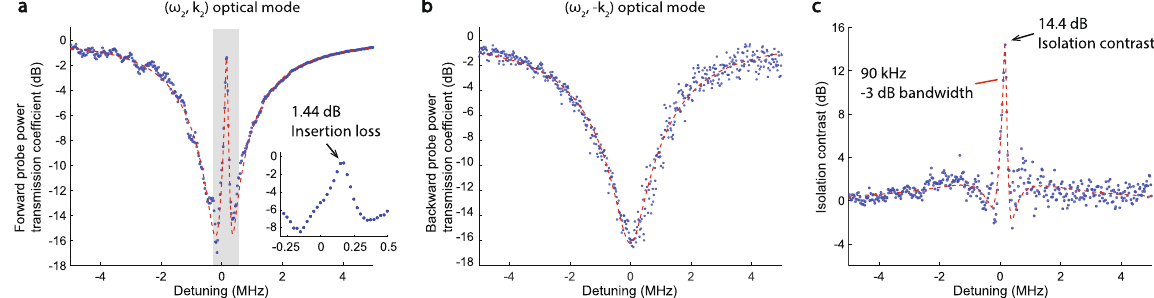
Figure 3. Experimental observation of extremely low insertion loss linear optical isolation. ( a ) Probe power 2 transmission coefficient ˜ t is measured in the forward direction through the waveguide near the ( ω 2 , k 2 ) mode, p with fixed 66 μ W pump power dropped into the ( ω 1 , k 1 ) mode. The forward probe power transmission coefficient through the waveguide shows only 1.44 dB insertion loss within the transparency. The phonon mode frequency is 145 MHz. ( b ) The ( ω 2 , − k 2 ) optical mode measured by the backward probe does not exhibit the induced transparency, resulting in conventional absorption of the probe signal by the resonator. ( c ) The optical isolation contrast is evaluated as the difference between forward and backward power transmission coefficients. Here we calculate 14.4 dB peak contrast with a − 3 dB bandwidth of 90 kHz. Isolation exists over 470 kHz.